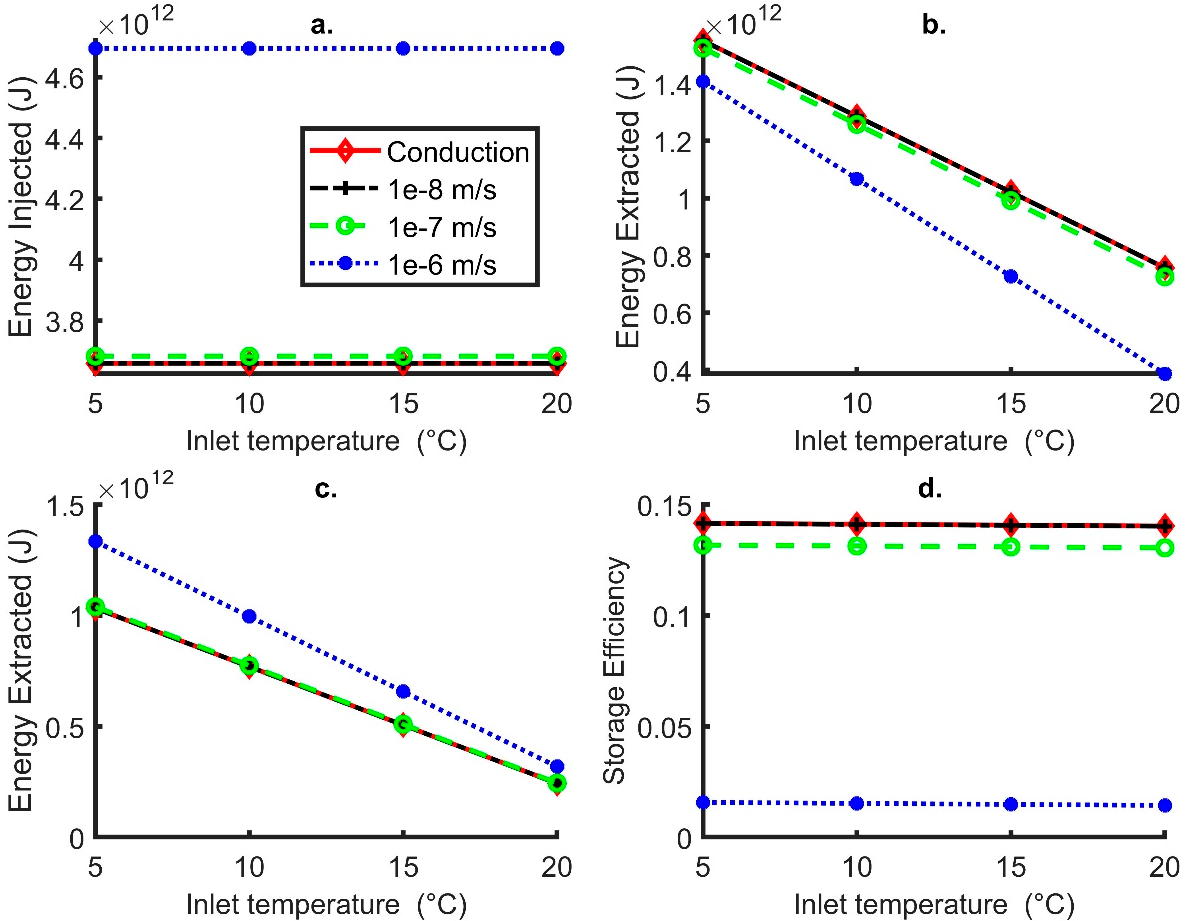
Figure 10. The impact of varying the constant DBHE input temperature during a 6 month heat discharge cycle, following a 6 month charge cycle. DBHE internal flow rate = 5 L/s and inlet temperature during charge was maintained constant at 95 °C. ( a ) energy injected during charge, ( b ) energy extracted during discharge cycle following charge, ( c ) energy extracted during 6 month discharge period without preceding charge and ( d ) storage efficiency calculated according to Equation (10).